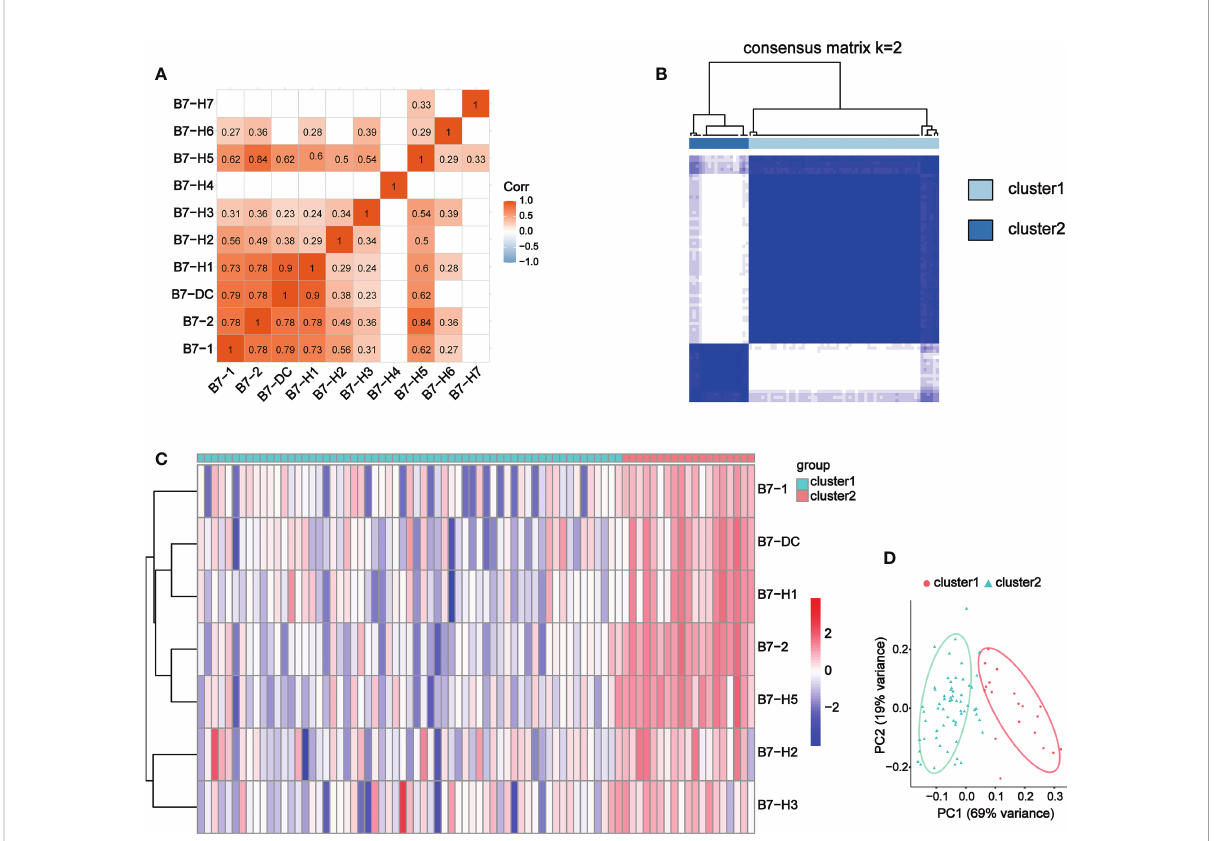
FIGURE 6 Co-expression analysis of B7 family. (A) Correlation analysis of B7 family. (B) Consensus clustering matrix for k = 2. (C) Expression heatmap of B7 family grouped by consistency of k = 2. (D) Principal component analysis (PCA) of 2 subtypes based on high and low expression of the B7